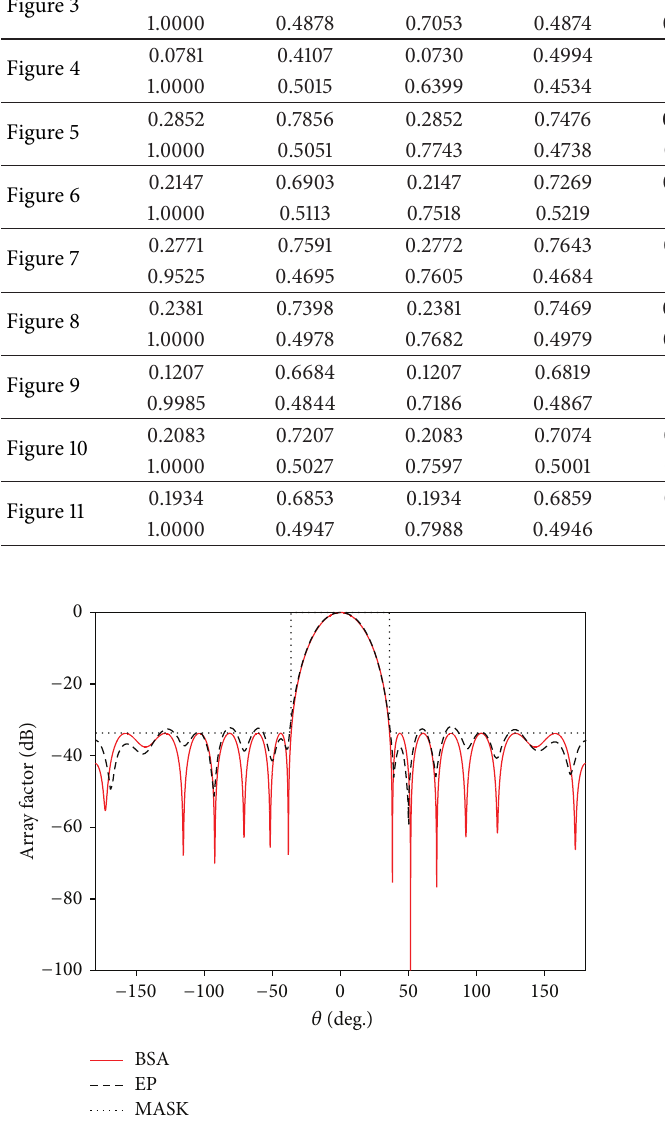
Figure 4: The radiation patterns obtained by BSA and PSO [1] for CCAA without central element